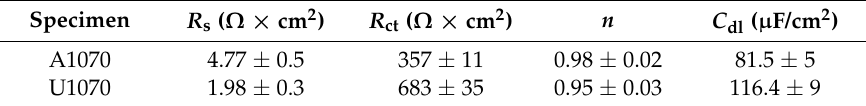
Table 6. Parameters extracted from electrochemical impedance spectroscopy (EIS) data of A1070 and